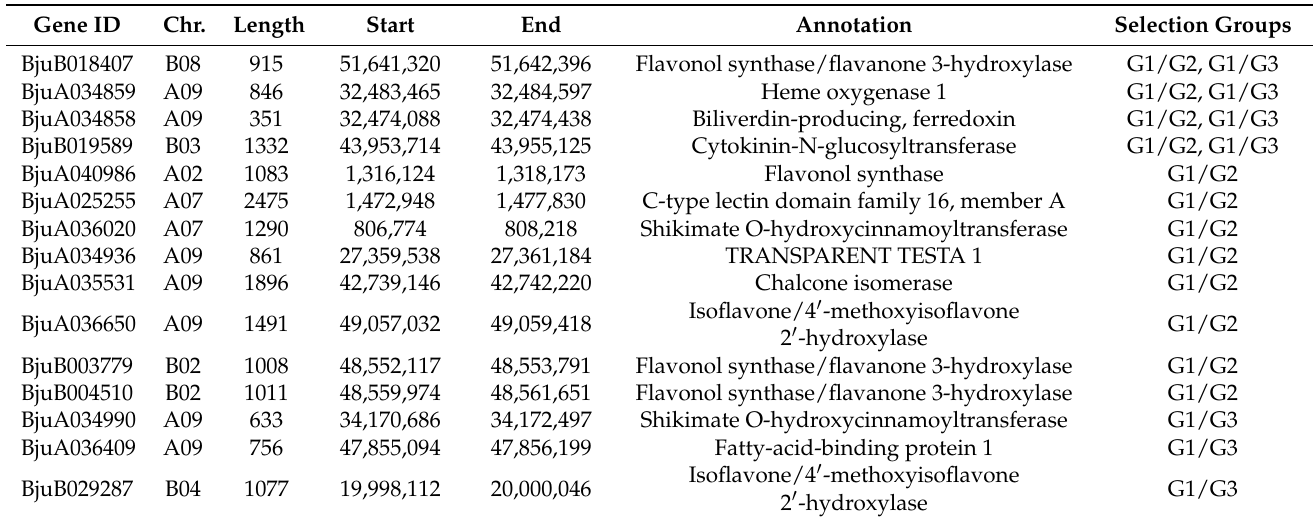
Table 2. Genes related to the flavonoid synthesis